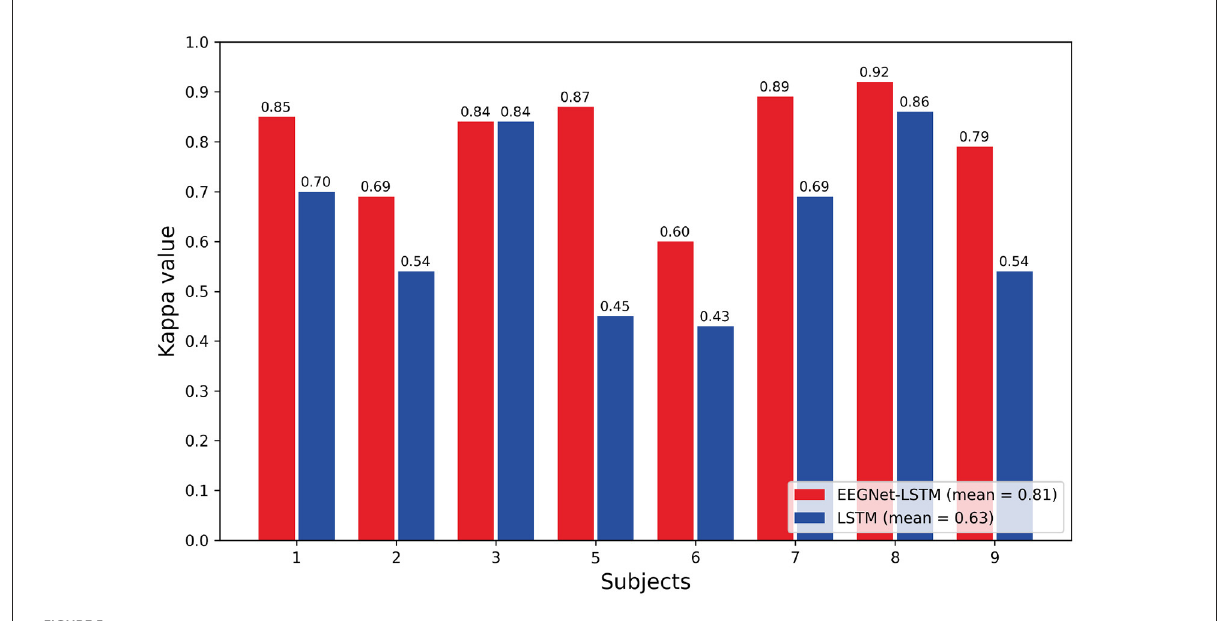
FIGURE5 Comparison of the kappa values obtained through the decoders.